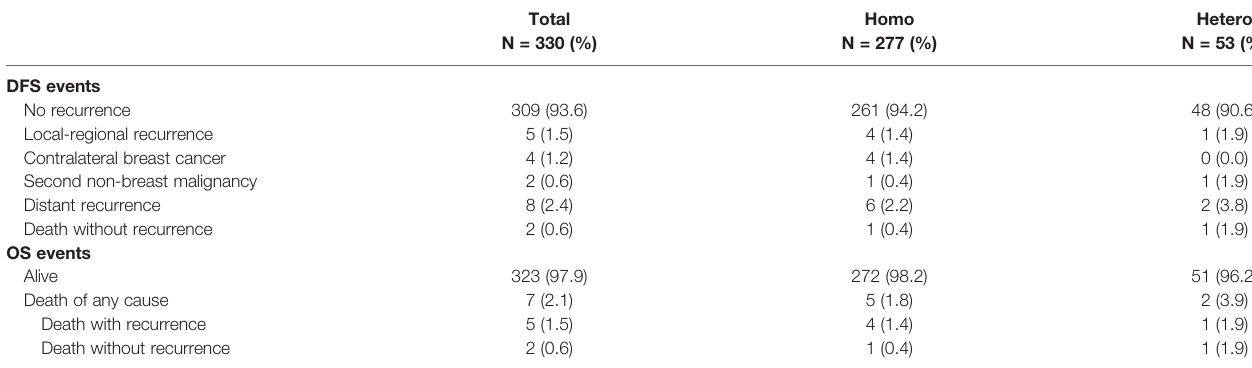
TABLE 4 | Details of DFS and OS events by status of molecular markers among 330 patients with at least two invasive tumor